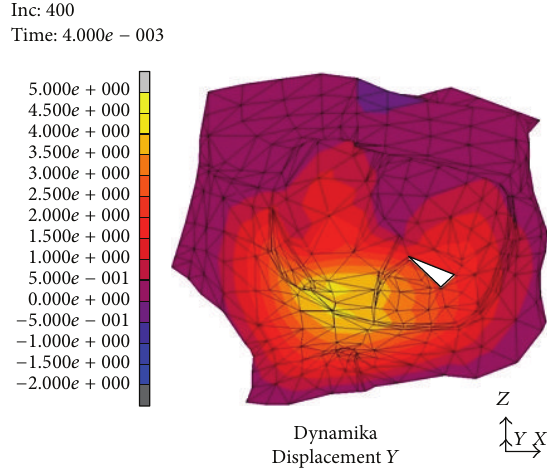
Figure 1: Dislocation after 𝑡 = 1 ⋅ 10 −3 s from the strike. Figure 2: Dislocation after 𝑡 = 4 ⋅ 10 −3 s from the strike.